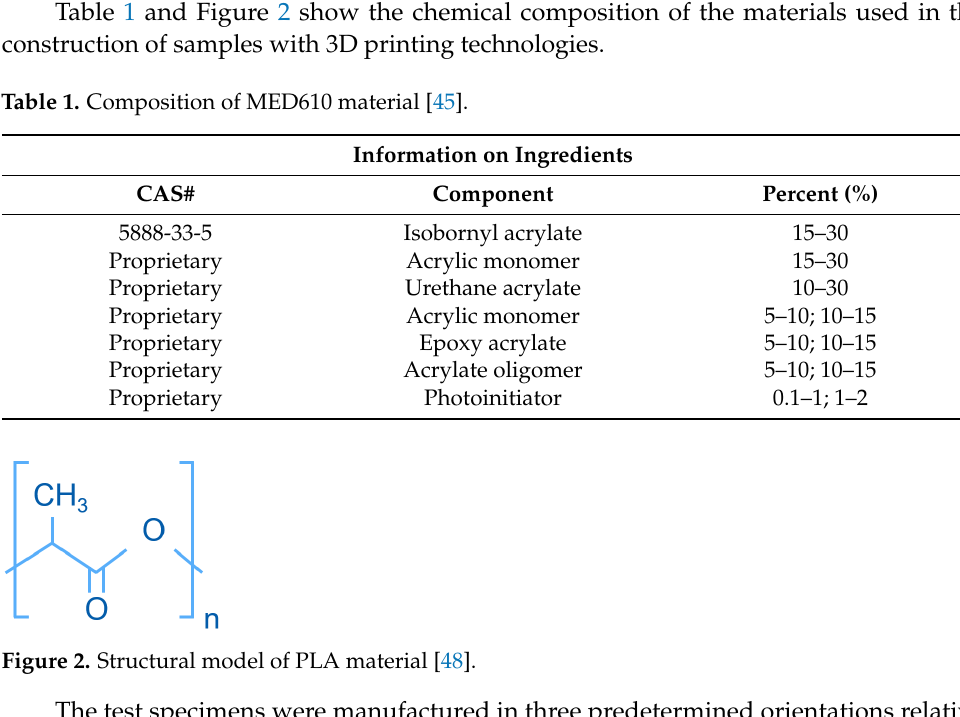
Table 1. Composition of MED610 material [45].